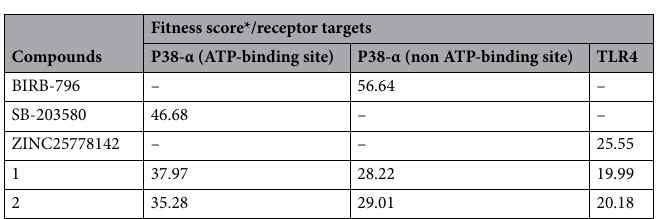
Table 1. Predicted binding affinity termed fitness scores toward focused receptor targets of 1 , 2 , and reference ligands. *Higher fitness scores indicated better binding affinity.